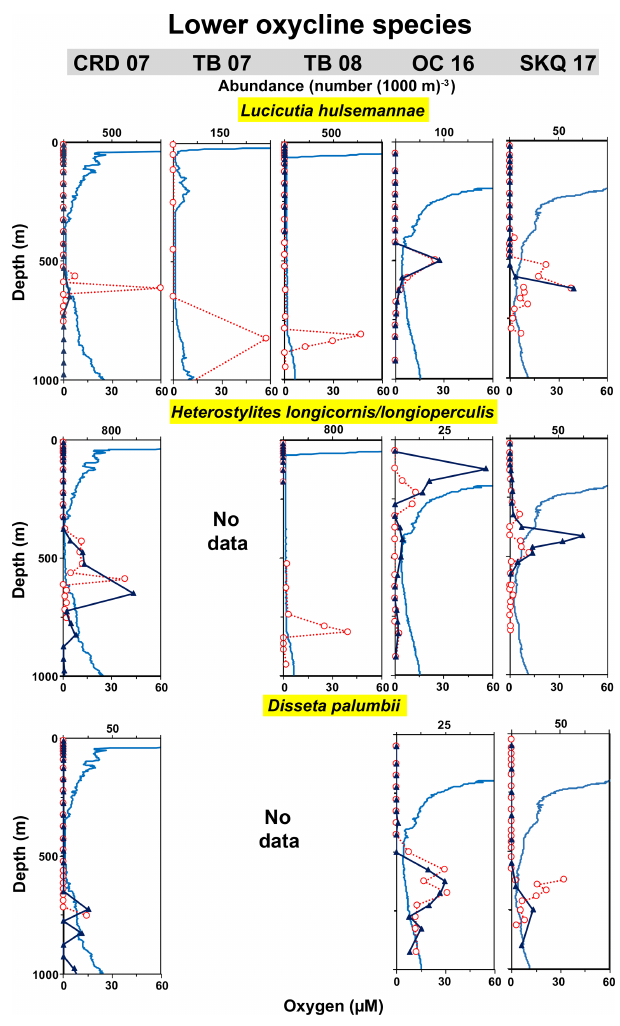
Figure 3. Vertical distributions relative to oxygen: lower oxycline species. Vertical distributions day (red) and night (dark blue) rel- ative to the oxygen profile (light blue) at each station from 0 to 1000m. Stations are noted at the top (station abbreviation and year), and each column comes from the indicated station. Each row is a different species. Missing boxes are locations and cruises where the species was not recorded. “No data” indicates that the species was either not present or not identified to species in those samples. “Absent” indicates that the species was searched for but not found (abundance = 0). Abundances (number(1000m) − 3 ) are for adults (combined females and males) and come from nets and tows listed in Table 1. Abundances are plotted at the mid-depth of the sampling interval. Horizontal abundance axes vary to highlight the peaks. Ta- ble S1 (Wishner et al., 2019) provides numerical abundance data for each net.